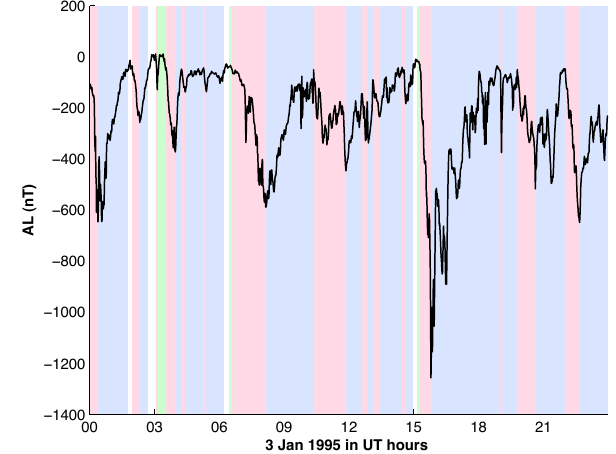
Fig. 1. An example of substorm phases identified from AL index: growth phase in light green, expansion phase in pink and recovery phase in light blue